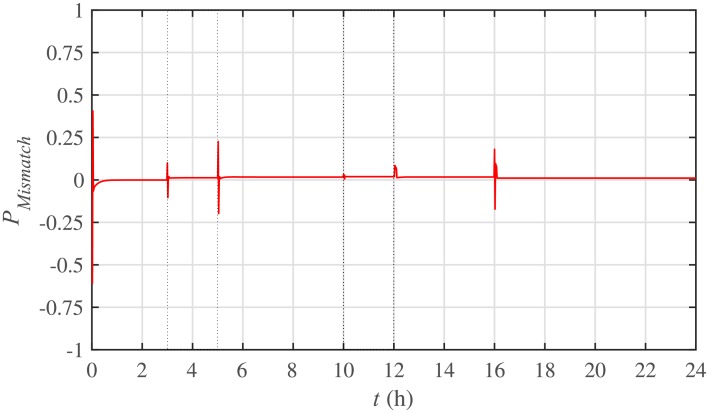
Power mismatch under case 2.